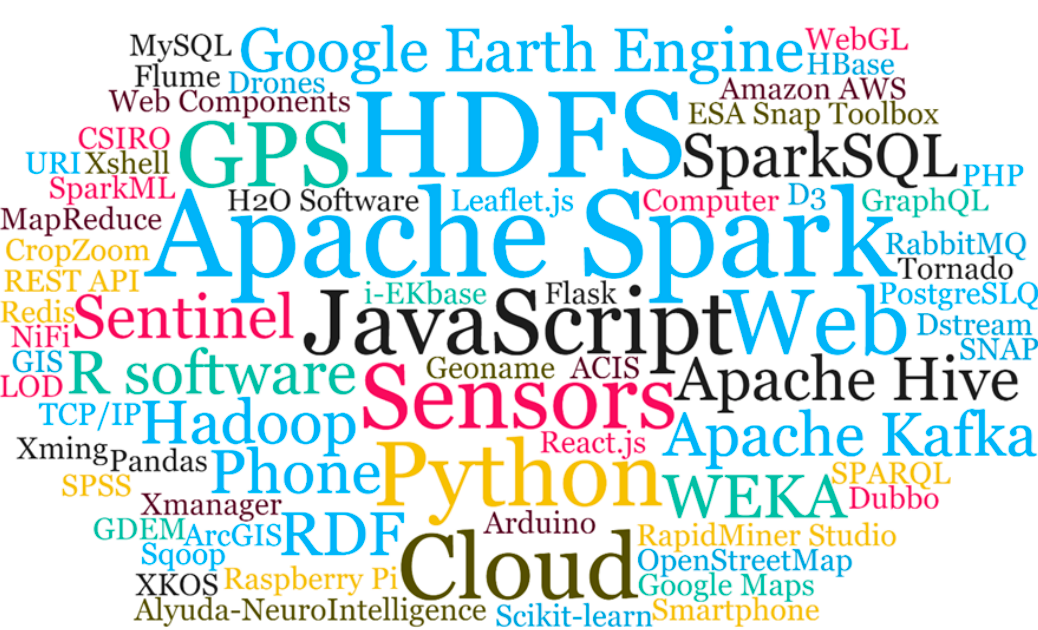
Figure 14. Main technologies used in agricultural Big Data and ML.